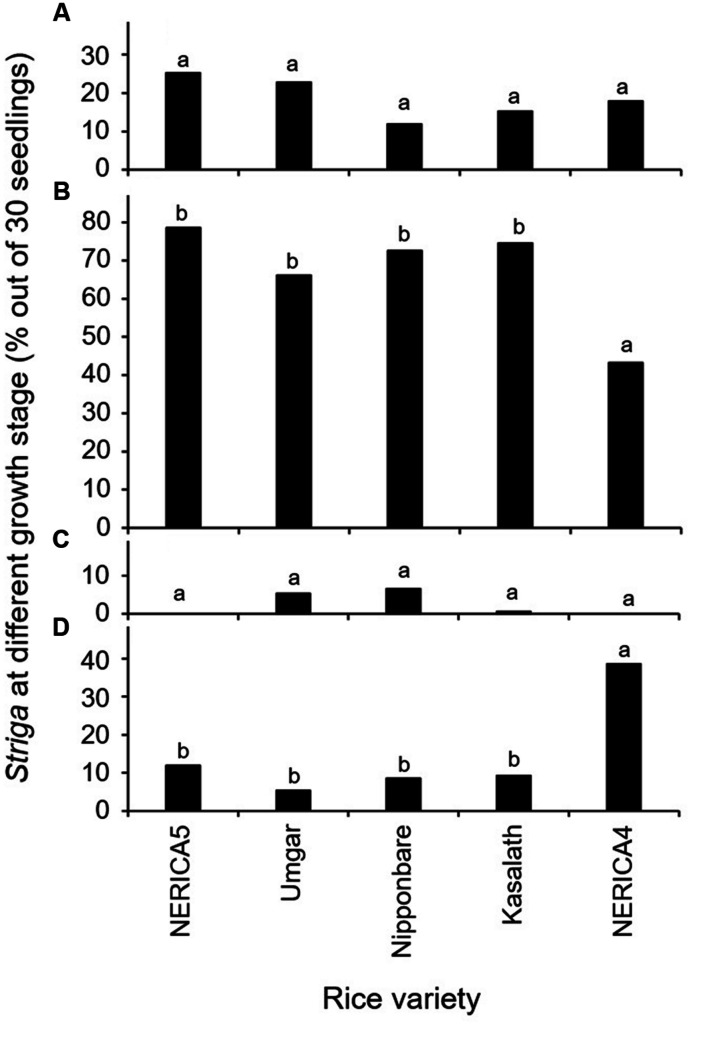
Percentage out of 30 seedlings of S. hermonthica at stage (A) I, failure to attach to the root due to a lack of haustorium formation (Figure 1a); (B) II, successful attachment but no shoot elongation (Figures 1b–d); (C) III, shoot necrosis after reaching the four or more leaf pairs stage (Figures 1e,f); and (D) IV, successful parasitism with healthy shoots (Figures 1g,h) on the roots of five rice varieties in the second rhizotron experiment at 21 DAI. Means followed by a common letter are not significantly different by Tukey’s HSD test in each growth stage (p < 0.05).